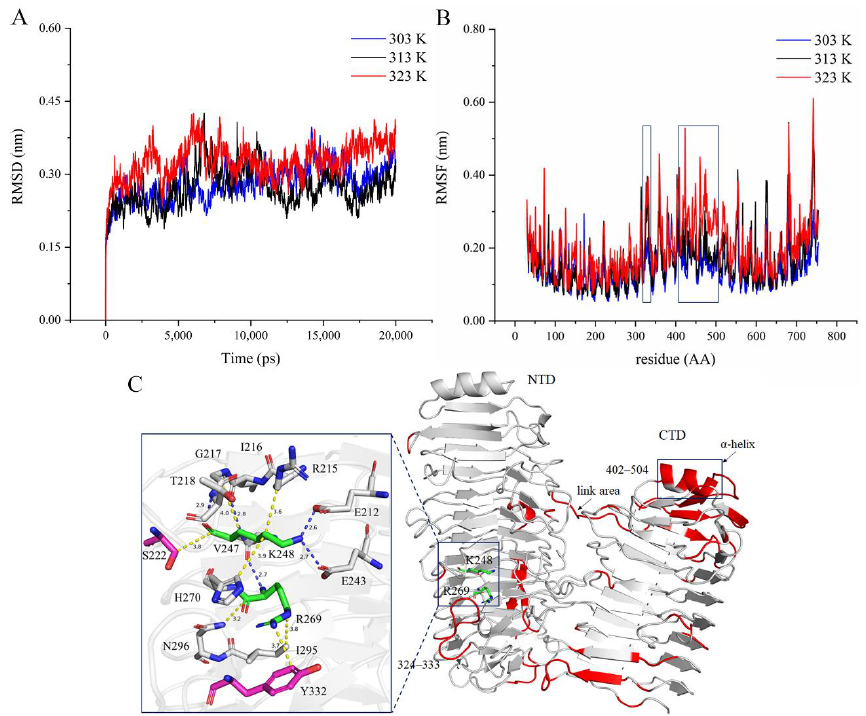
Figure 7. ChSase B6 at different simulation temperatures. ( A ) RMSD of ChSase B6 at 303 K (30 °C), 313 K (40 °C), and 323 K (50 °C); ( B ) RMSF of ChSase B6 at 303 K (30 °C), 313 K (40 °C), and 323 K (50 °C). ( C ) The enzyme flexibility changes from the simulation temperature 303K to 323K. Red is the area of increased flexibility. In the residue interaction diagram, the bonds in yellow and blue represent van der Waals forces and hydrogen bonds, respectively.